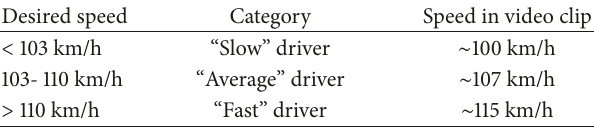
Table 1: Categorization of respondents into three